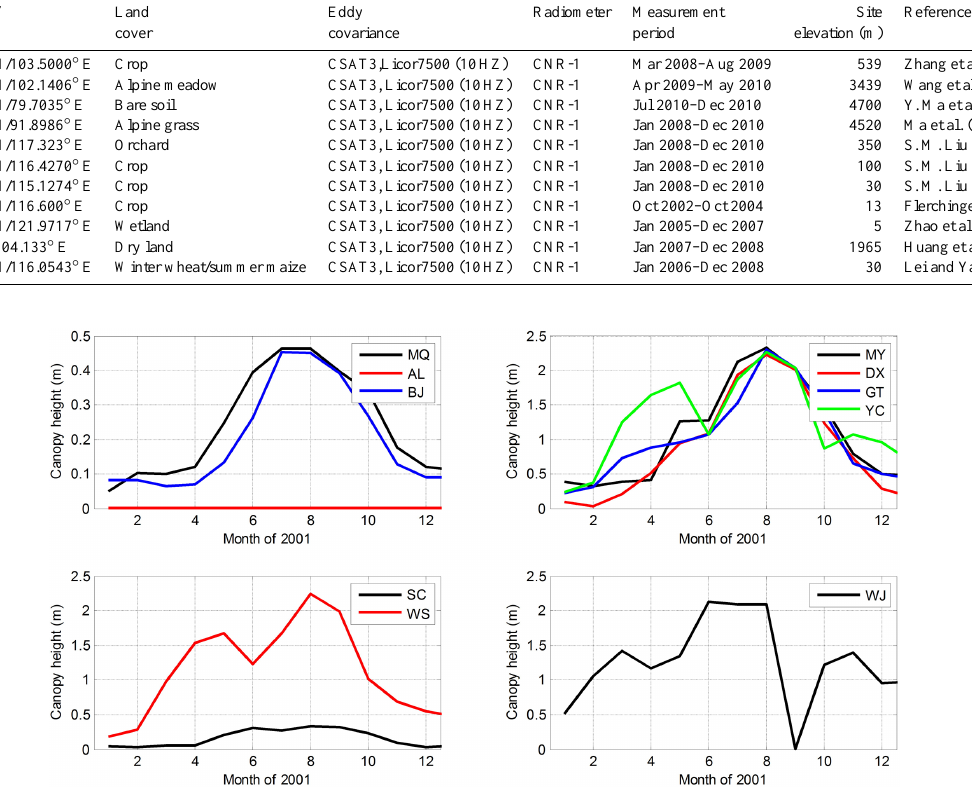
Figure 3. Monthly variation of canopy height at the 10 flux